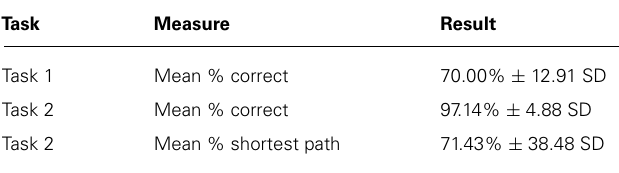
Table 2 | Summary of navigation task performance.